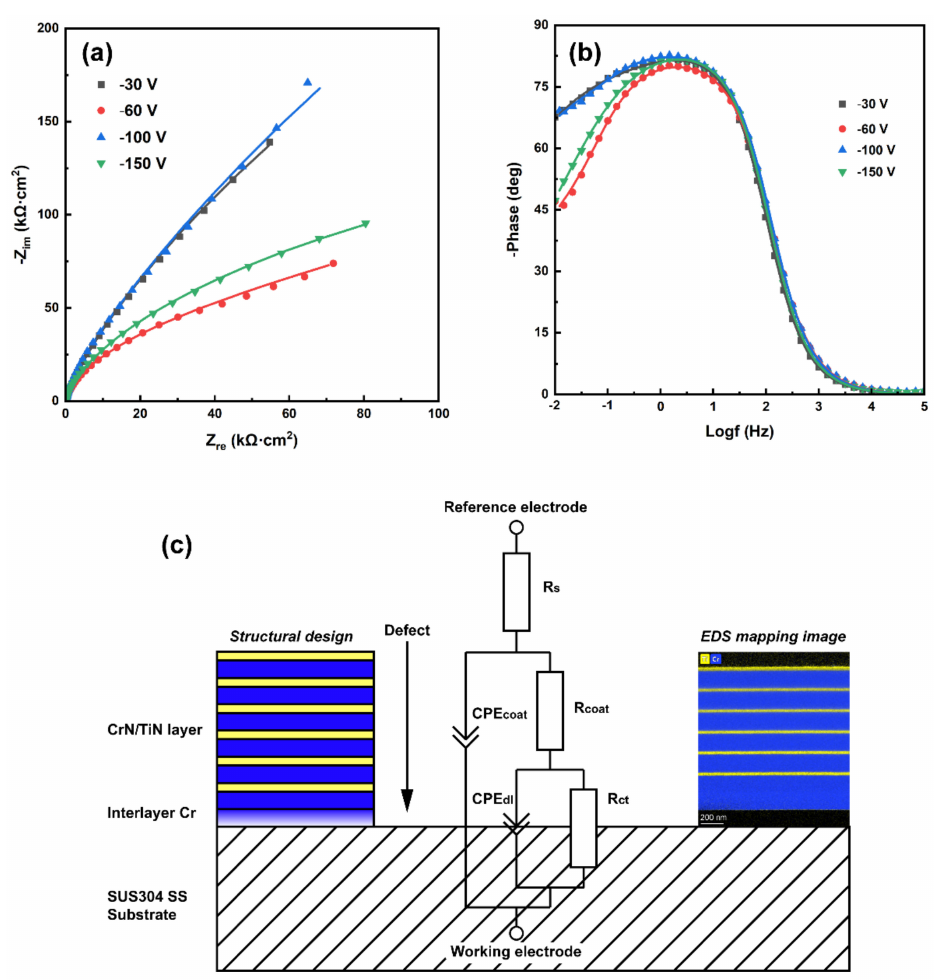
Figure 15. ( a ) Nyquist and ( b ) bode plots of the coatings at respective OCP in a 3.5 wt.% NaCl solution and ( c ) electronic equivalent circuit used in the fitting procedure of the EIS